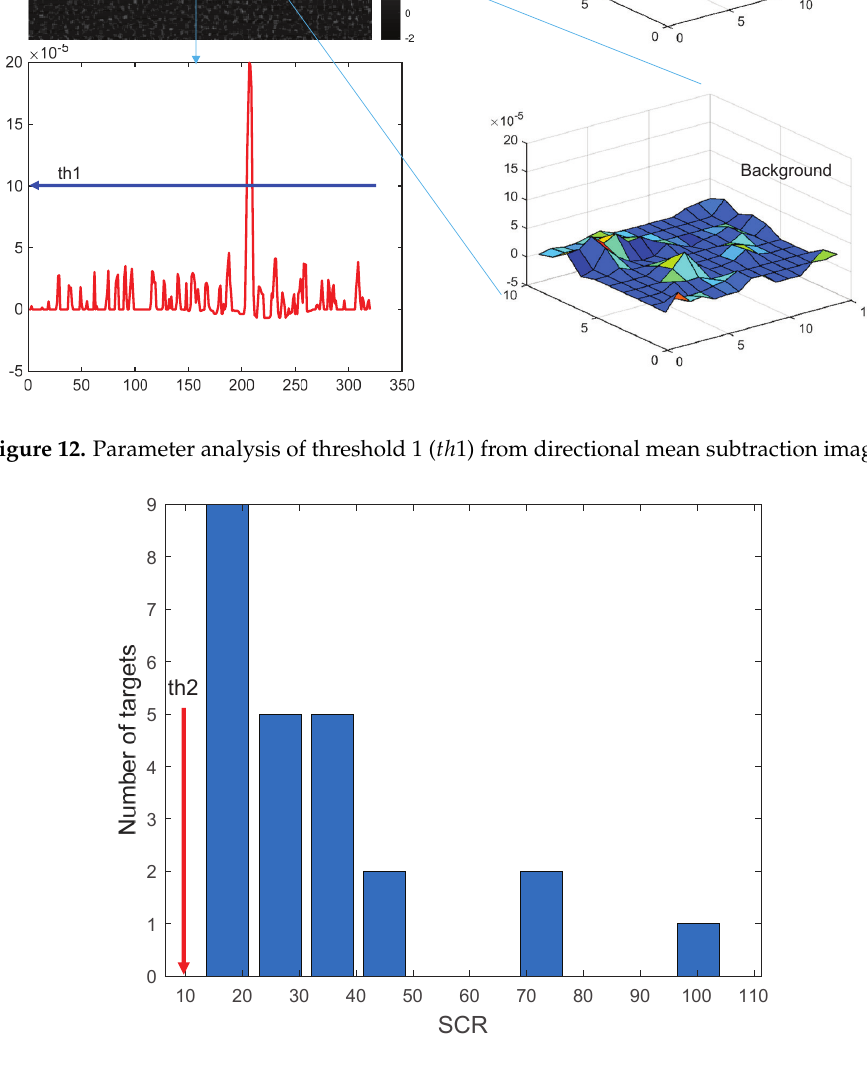
Figure 13. Parameter analysis of threshold 2 ( th 2) from statistics of SCR values of different